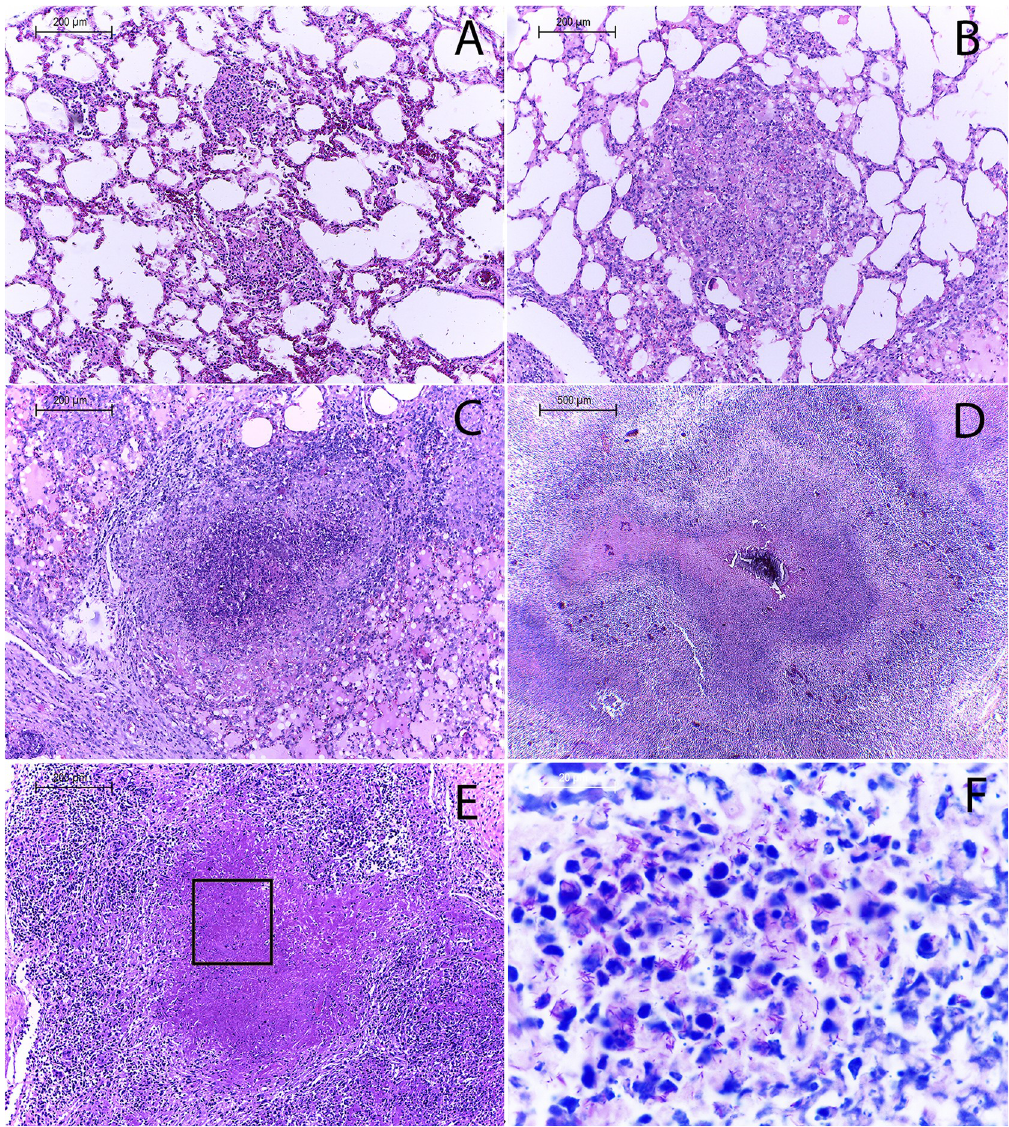
Fig 5. Histopathological classification of granulomas found in lung tissue from calves. H&E ( A.-C 200x, D-E 40x F.- 1000x). (A) Stage I. (B) Stage II. (C) Stage II-III. (D) Stage III-IV. (E) Close up of stage II-III. (F) Zielh Neelsen 1000x with abundant extracellular acid-fast bacilli in stage